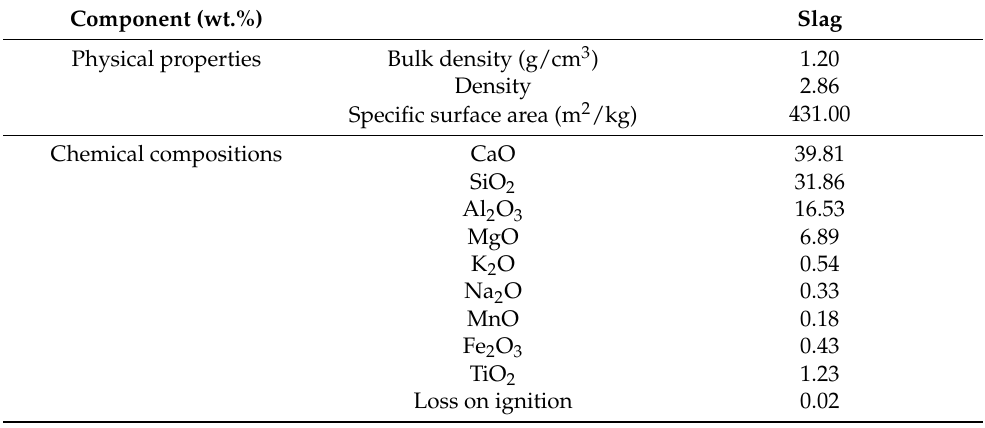
Figure 1. GGBFS’s particle size distribution. Table 1. Properties of the GGBFS.